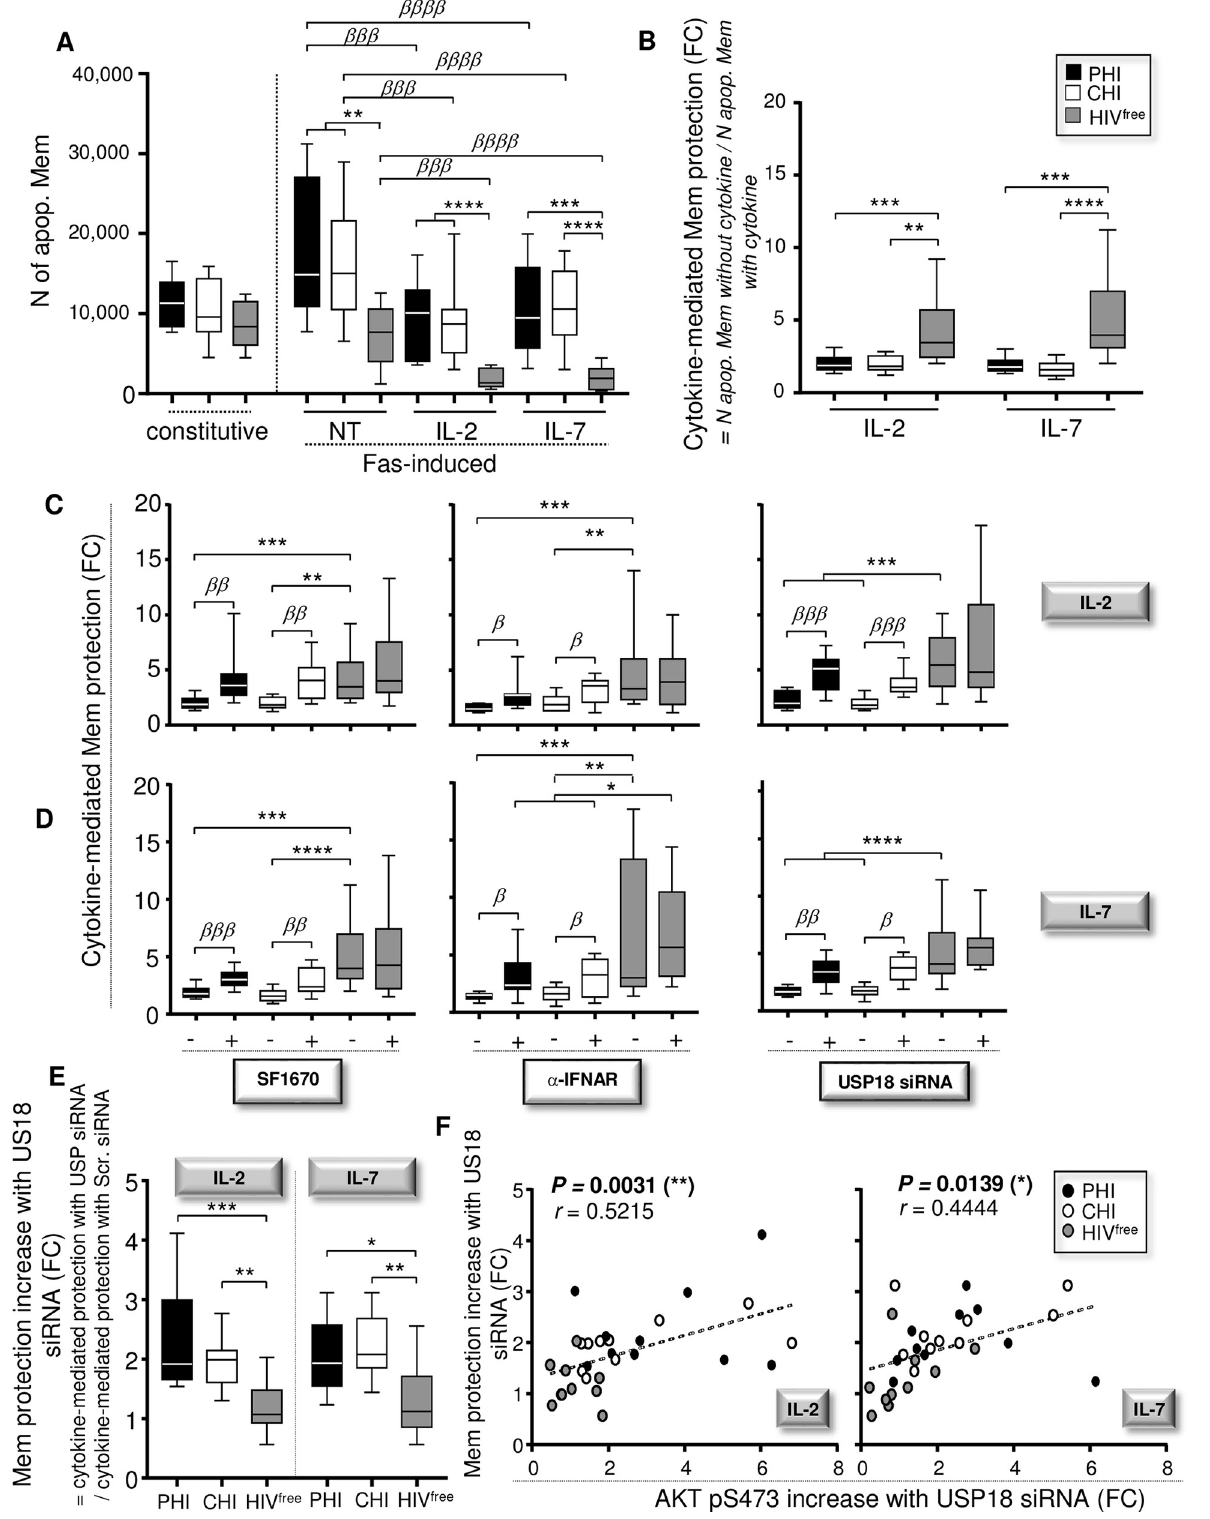
Fig 3. Interfering with USP18 in Mem from PHI and CHI improves cytokine responses and cell resistance to apoptosis. ( A ) Numbers (N) of constitutive apoptotic Mem (without any treatment) and Fas-induced apoptotic Mem in the presence or absence of IL-2 or IL-7 stimulation. N of